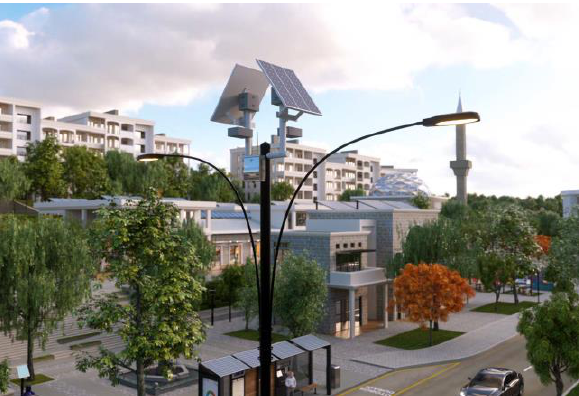
Figure 2. A view from the detailed 3D model of Bizimsehir.